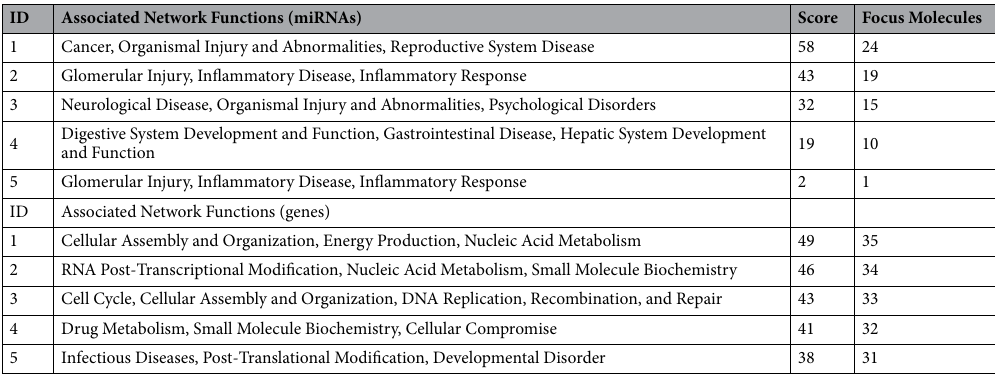
Table 3. Top five associated network functions predicted by an IPA analysis of miRNA and mRNA in